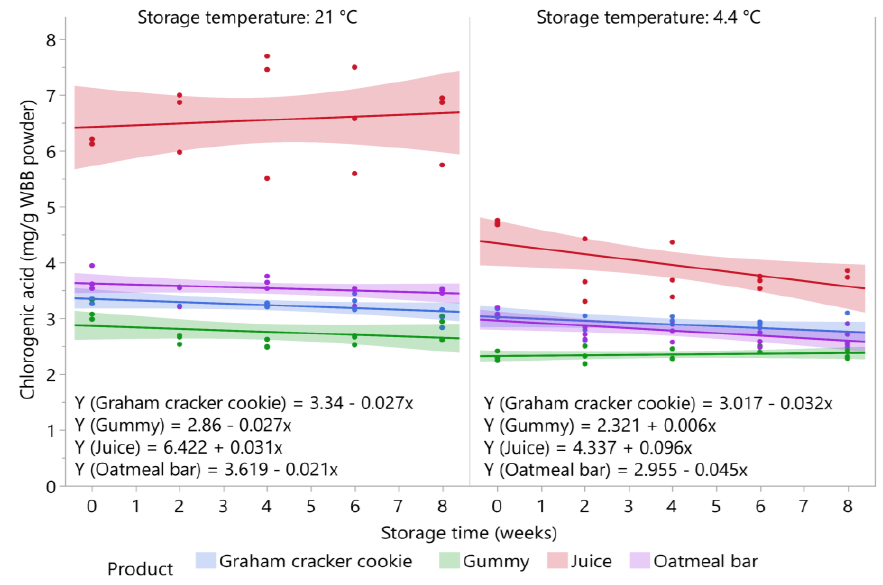
Figure 5. Stability of chlorogenic acid in blueberry stored at 21 °C and 4.4 °C ( n = 3/time point). Shaded area around lines represents 95% confidence intervals for predicted values.